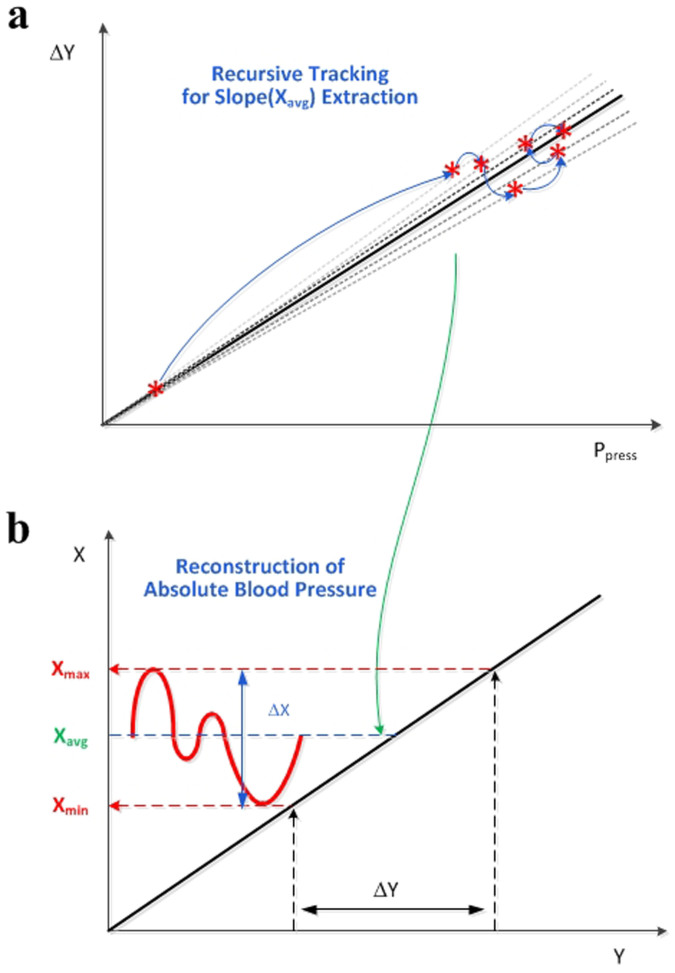
Recursive tracking of blood-pressure measurement.(a) Real-time slope tracking process in ΔY versus Ppress plot. The line slope is cumulatively updated by last measured value. (b) Reconstruction process of radial artery's blood pressure (i.e., systolic pressure Xmax and diastolic pressure Xmin) corresponding to updated Xavg which is calculated from ΔY-Ppress line slope.